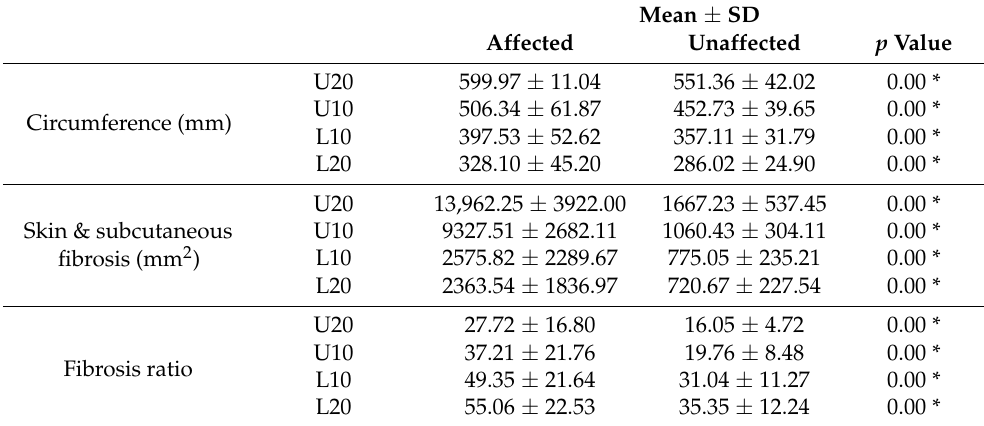
Table 2. Comparison of parameters between affected and unaffected limbs in the initial CT